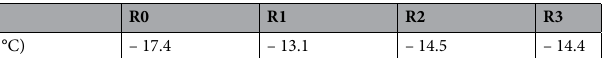
R0 R1 R2 R3 Tg (± 0.3 °C) Table 2. The Tg values of the soft segments at different reprocessing cycles for the 80 wt% MRE.